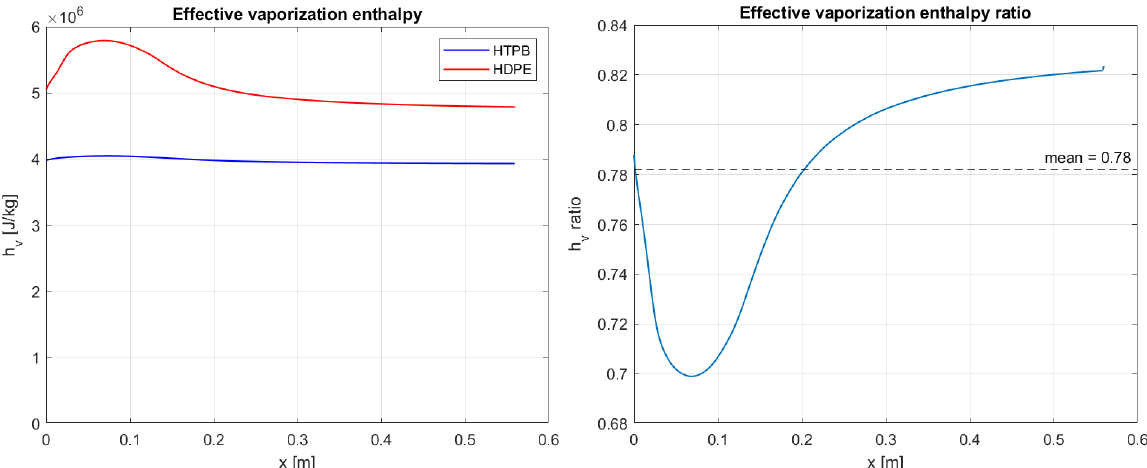
Figure 17. Comparison between HDPE and HTPB vaporization enthalpies obtained from the CFD simulations.